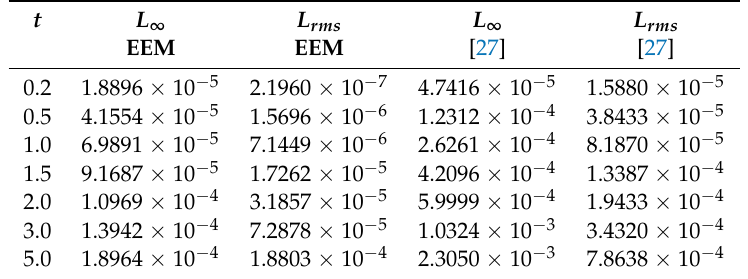
Table 8. Comparisons between the results obtained by the LMM with those adapted from [27] for Test Problem